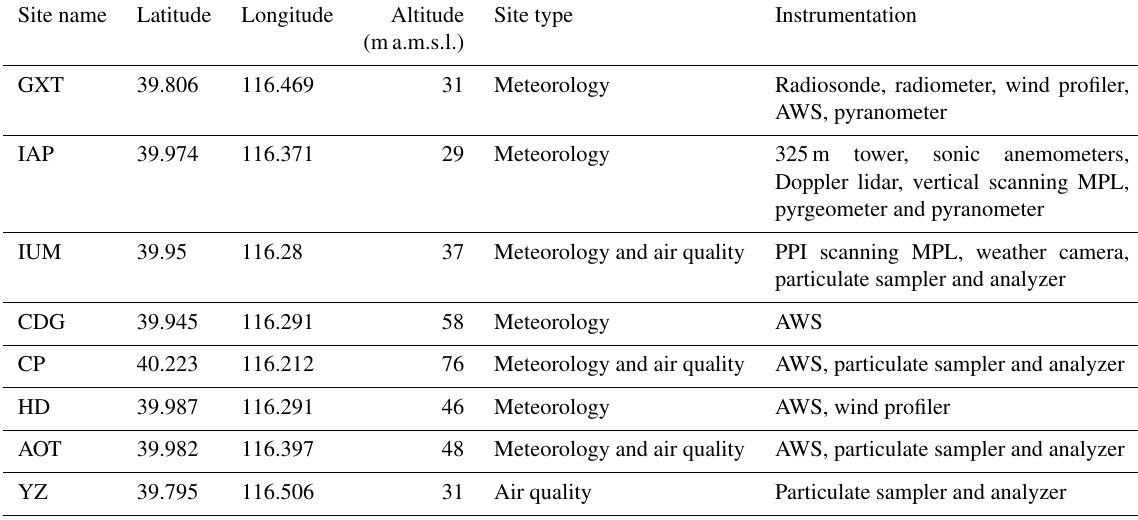
Table 1. Latitude, longitude, altitude, site type and instrumentation at the main sites in Fig.